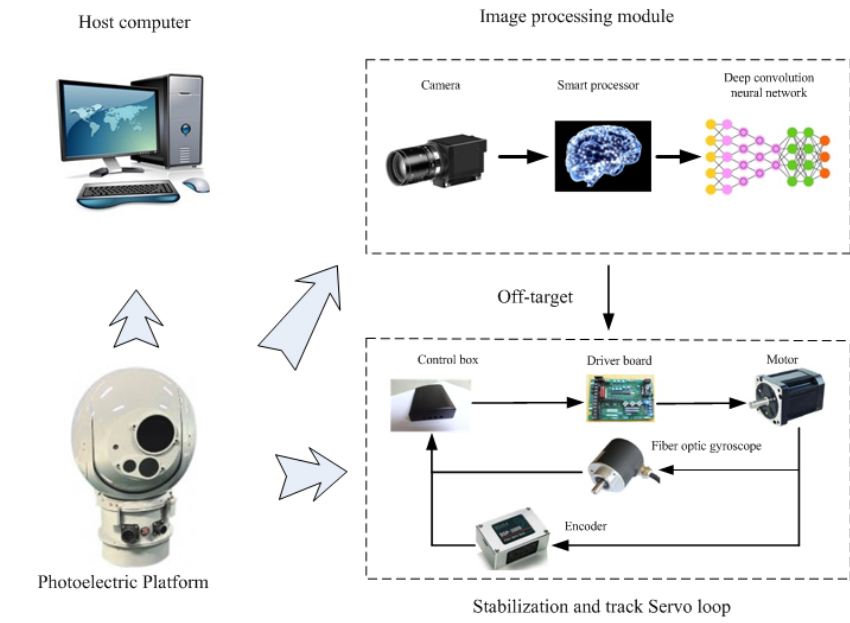
Figure 1. Photoelectric platform